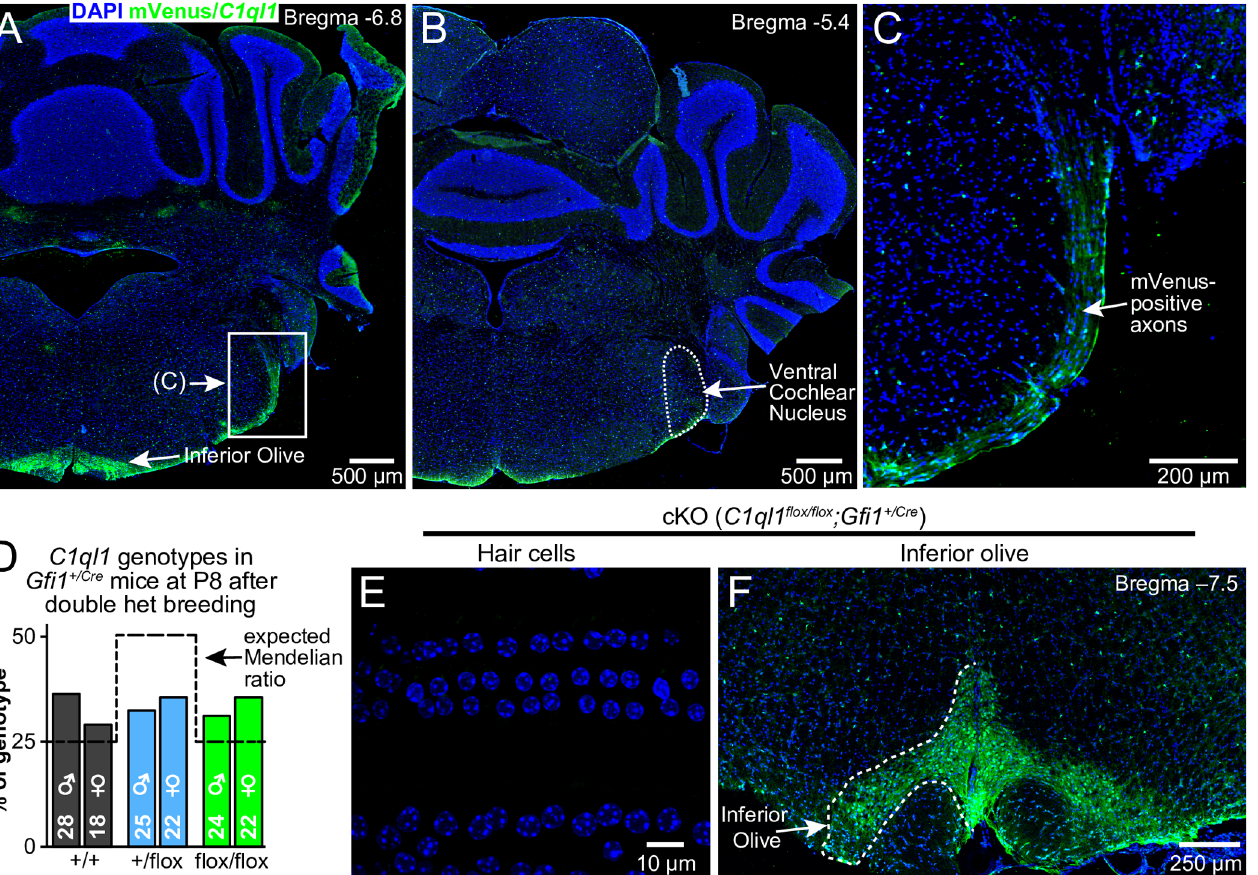
Fig 3. C1ql1 is not expressed in cochlear nucleus and creation of C1ql1 cKO mice. (A, B) Representative mVenus localization in coronal sections from adult C1ql1 flox/flox mouse hindbrain. (C) Magnified view of the boxed region in panel A. (D) Genotyping results from cross of double heterozygous parents. Only pups heterozygous for the Gfi1 +/Cre allele are graphed. Dashed line indicates the expected Mendelian ratio. (E) Representative image from a 10-week-old cKO ( C1ql1 flox/flox ; Gfi1 +/Cre ) mouse taken at a similar frequency location as in panel 2E. (F) Representative mVenus localization in coronal section from adult cKO mouse hindbrain.